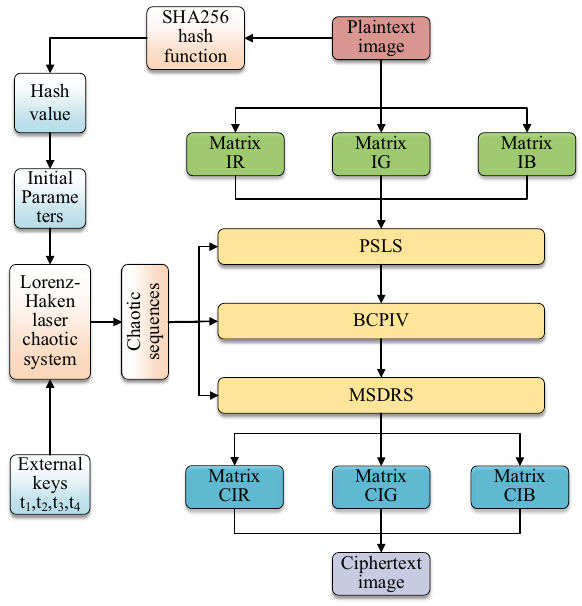
Fig. 1 The flowchart of the proposed image encryption